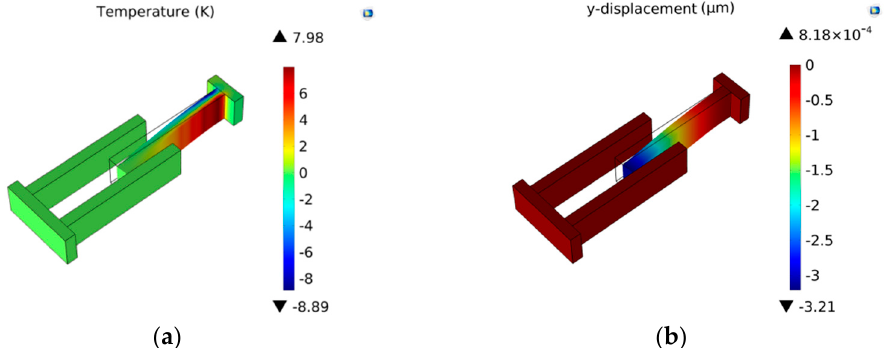
Figure 10. The path analysis results of temperature and displacement variation.